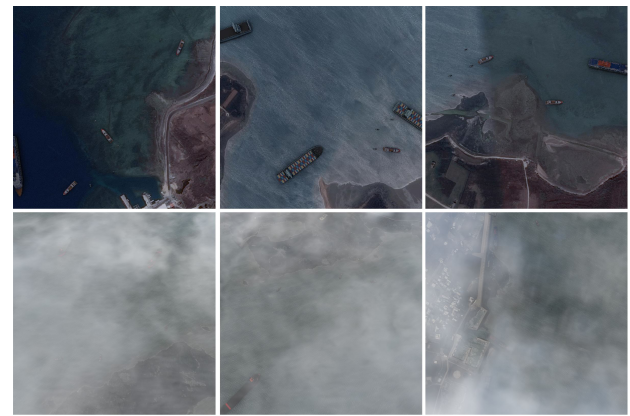
Figure 9. Typical images in Normal dataset (the first row) and Cloudy dataset (the second row). The network is trained with an Adam optimizer on GTX1080ti GPU with 2 images from different datasets per mini-batch. The input image is resized such that its shorter